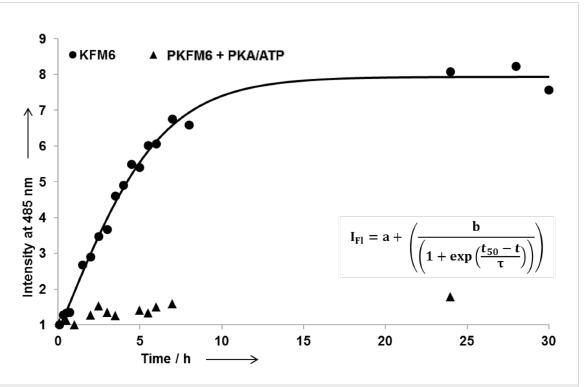
Figure 2: ThT-binding assay of of 15 µM KFM6 in 50 mM Tris/HCl buffer with 10 mM MgCl 2 at pH 7.5, 24 °C, and a ThT concentration of 20 µM. The amyloid growth process was monitored for untreated peptide (circles) and peptide in the presence of PKA and ATP